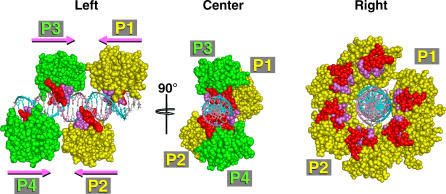
Modeling Studies of the T-ag obdA model of four T-ag obds engaged with DNA containing P1 through P4. Starting with the x-ray coordinates of the co-structure of two T-ag obds on P1 and P3, a model was generated of four T-ag obds engaged with the four pentameric binding sites P1–P4. As stated in the text, assembly of the double hexamer of T-ag does not require all four pentanucleotides, although all four are required for unwinding. However, given that the origin contains four pentanucleotides and the structure does not predict any steric clashes when all four are sites are occupied, it is likely that all four are occupied by the obd at some point during assembly. The DNA is colored as Figure 2A. The T-ag obds are shown as van der Waals spheres. The obds that engage with P1 and P2 will presumably comprise one hexamer (yellow). The obds that engage with P3 and P4 will presumably comprise the second hexamer (green). The A1 and B2 loops that engage with the DNA are colored red and purple, as in Figure 2A. The 5′ → 3′ direction of the GAGGC sequences is indicated by arrows and labeled.(Left) In this view, the obds bound to P1 and P3 (or P2 and P4) are oriented head-to head. As stated in the text, obds bound to P1 and P3 (or by extension, P2 and P4) are close but do not contact. This model also shows that the obds on adjacent pentamers (P1 and P2 or P3 and P4) do not interact with each other.(Center) This view is looking down the axis of the DNA and shows clearly that the obds bound to adjacent pentamers occur on opposite faces of the DNA.(Right) This is a view of spiral hexamer of T-ag obd, with the DNA interacting loops colored the same as in the other panels. Duplex DNA is modeled along the central channel of the spiral. The obds that are 180° apart and could have previously interacted with binding sites (eg, P1 and P2) are indicated. This figure illustrates two important points. First, the approximately 30-Å-diameter channel of the spiral hexamer positions the obds farther from the DNA than when engaged site-specifically. Second, the position of the DNA binding loops in red and purple indicates that a significant rotation of the obds must occur to transit from the sequence-specific DNA binding structure to the spiral structure.